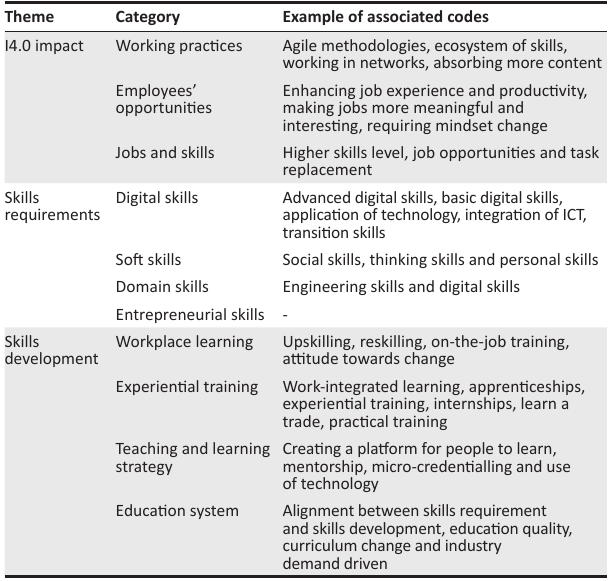
TABLE 2: Emerging themes, categories and associated